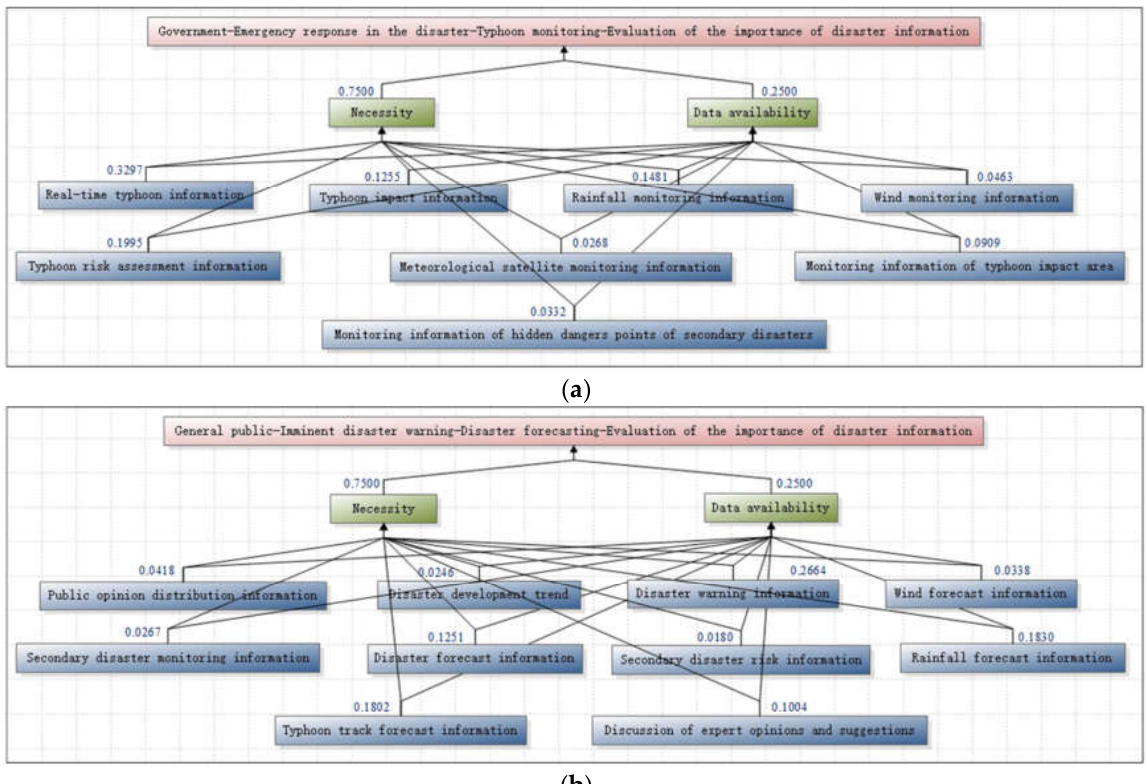
Figure 7. ( a ) The typhoon monitoring information weight distribution map of the emergency response in the disaster of the government. ( b ) The disaster forecasting information weight distribution map of the immediate disaster warning of the general public.